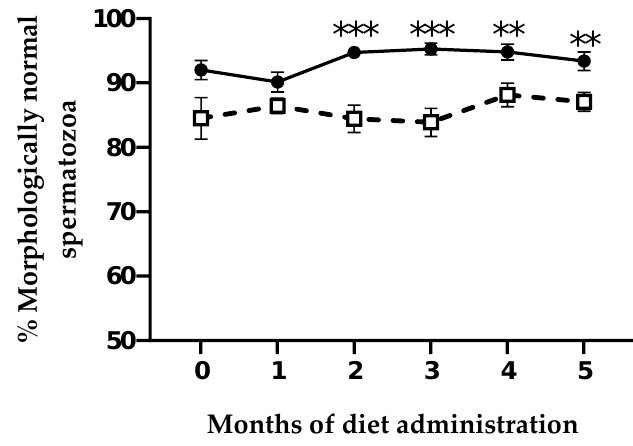
Figure 4. Percentage of sperm cells with normal morphology in samples from animals fed with a phytomelatonin-rich ( • ) or commercial (control, (cid:3) ) diet from month 0 (before diet administration) to month 5. Values are shown as mean ± S.E.M., n = 16. ** p < 0.01 and *** p < 0.01 indicate significant differences between both experimental groups.